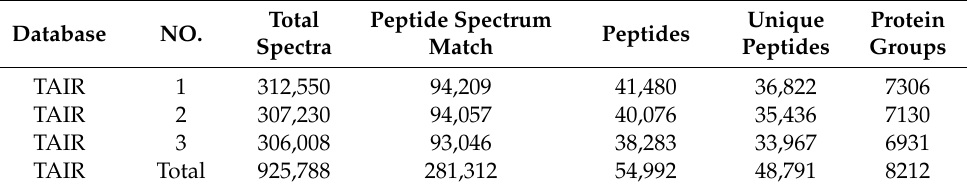
Table 1. Information about the